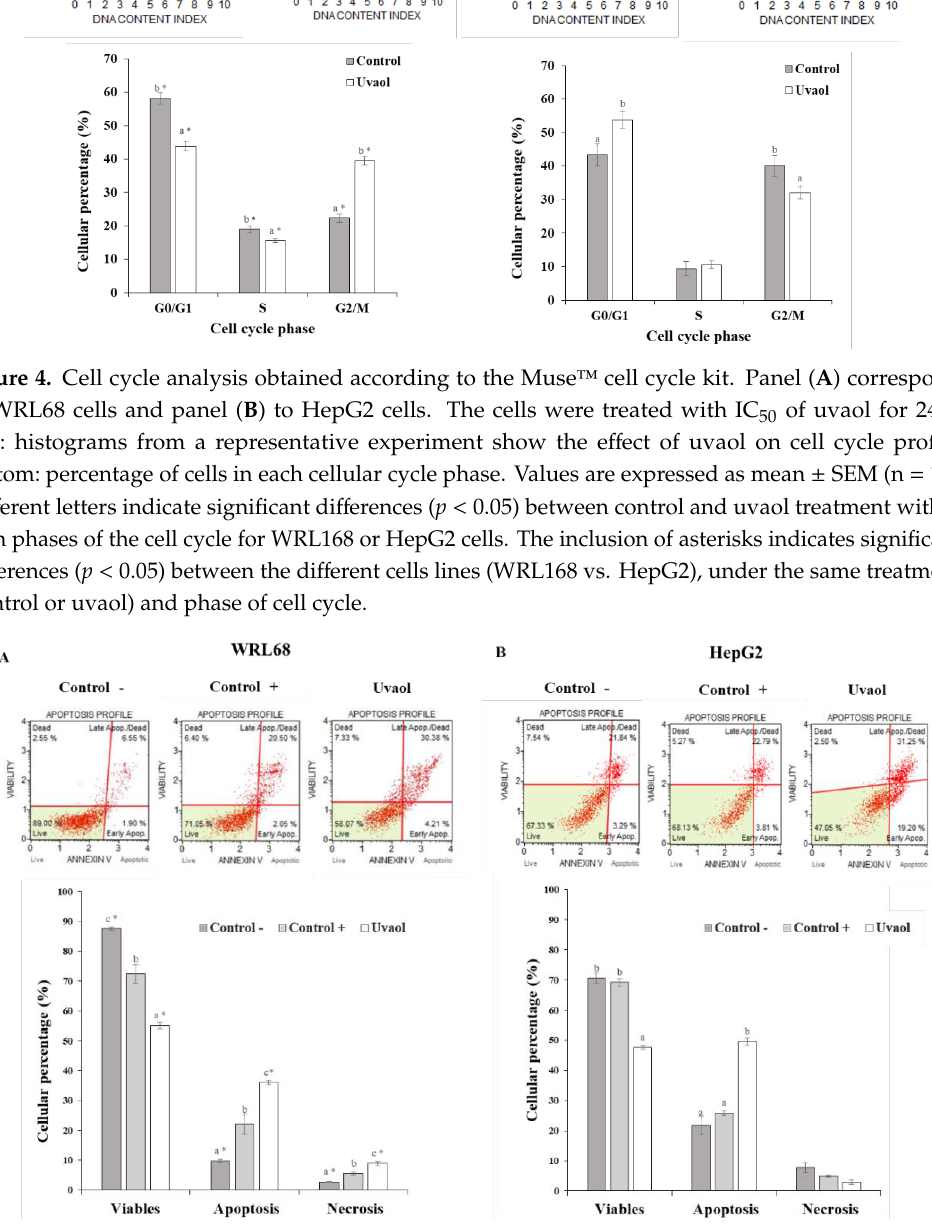
Figure 5. Apoptosis analysis obtained according to the Muse™ apoptosis kit. Panel ( A ) corresponds to the WRL68 cells and panel ( B ) to the HepG2 cells. Treatments included cells not treated (negative control) and cells incubated with staurosporine (1 μg/mL, positive control) or IC 50 of uvaol for 24 h. Top: dot plots show a representative experiment of the different treatments. Bottom: percentage of lived, apoptotic and necrotic cells for each treatment. Values are expressed as mean ± SEM (n = 12). Different letters indicate significant differences ( p < 0.05) between control and uvaol treatment within apoptosis stage (viable, apoptosis or necrosis) for WRL168 or HepG2 cells. The inclusion of asterisks indicates significant differences ( p < 0.05) between different cells lines (WRL168 vs. HepG2), under the same treatment (control or uvaol) and apoptosis stage.